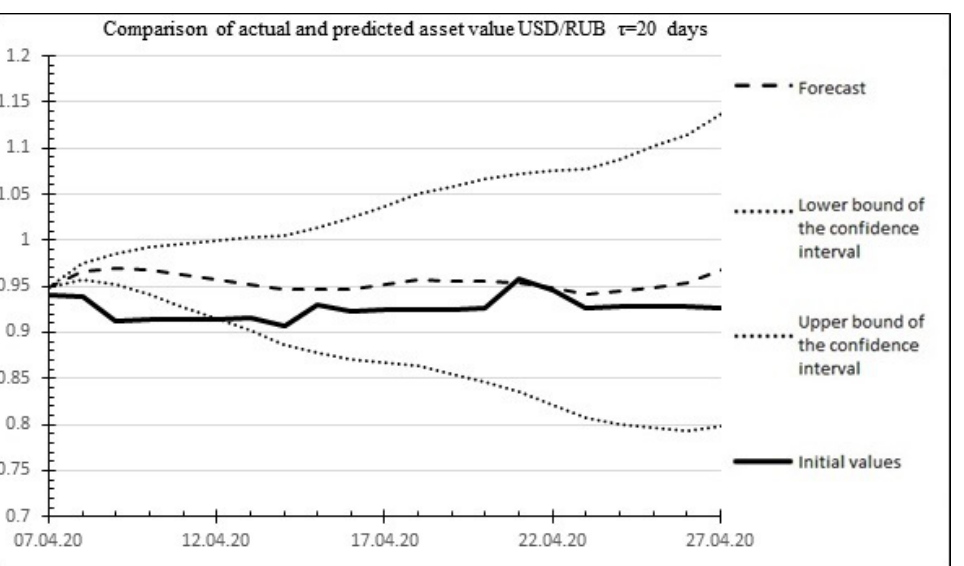
Figure 8. Comparison of the results of the 20 days ahead forecast of the USD/RUB asset value with actual